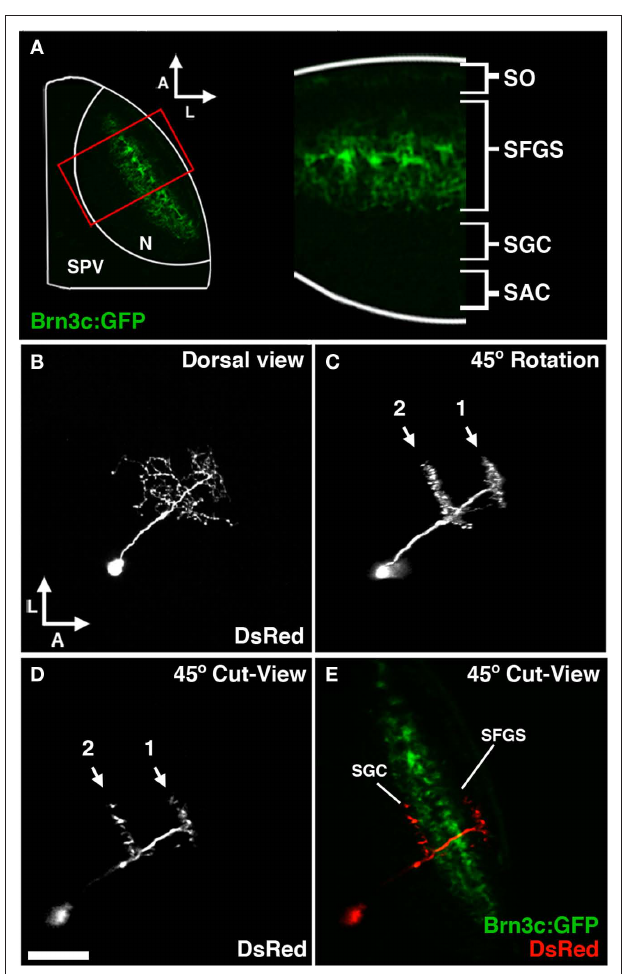
FiGure 4 | Morphological analysis of neurons labeled by dg4ii plasmid. (A) Approach used to determine laminar targeting of neurites in the tectal neuropil. Image of pou4f3:gfp fluorescence, which labels a subset of RGC axons that target the SO and the two deepest sublayers of the SFGS. This signal was used to determine the relative thickness of the SO and SFGS layers, which receive the vast majority of retinal afferents. (B) Maximum projection of a confocal image volume obtained from a single tectal neuron at 5 dpf labeled by blastomere injection of dg4ii and uas:dsred plasmids. Note the single apical neurite that gives rise to a compact arbor lacking an efferent projection. (C) Forty-five degree rotation of 3D volume rendering performed on image stack in B reveals precise stratification of two distinct arbors. (D) Cut-view at the same 45 ° orientation as in (C) demonstrates the roughly 45 ° orientation of the apical dendrite. (e) A merged image of cut-view in ( D ; red) and pou4f3:gfp fluorescence (green) reveals that the superficial arbor targets the SFGS layer, whereas the deeper arbor targets the SGC layer below the SFGS. Scale bar, 50 μm in (A) , 25 μm in (B–e)